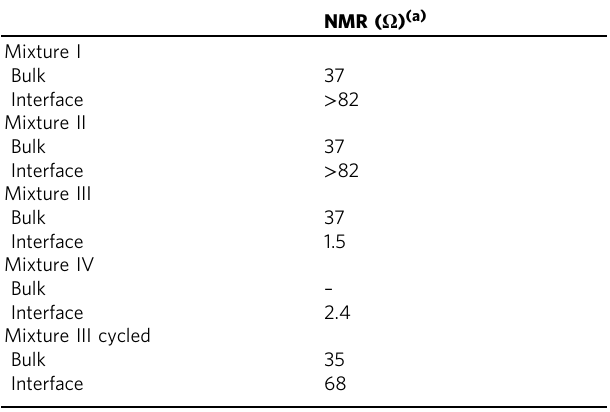
Table 1 Bulk and interface resistances of the mixtures derived from the conductivity in Fig. 4 determined from the NMR exchange